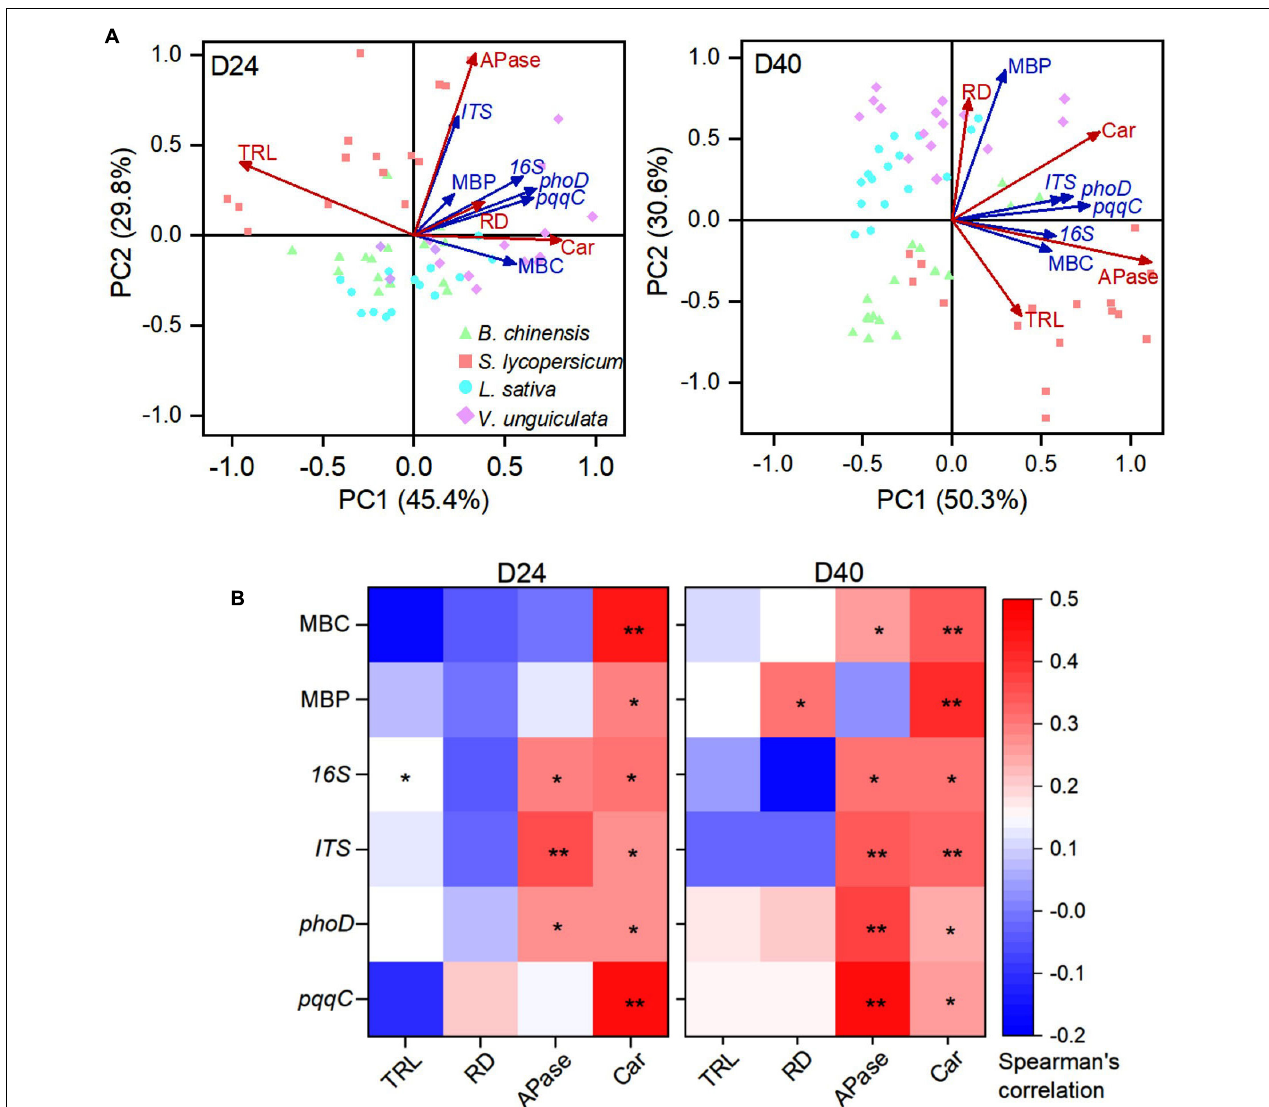
FIGURE 4 | (A) Principal component analysis (PCA) and (B) spearman’s rank correlation matrices between four root traits and six soil microbe traits B. chinensis , S. lycopersicum , L. sativa , and V. unguiculata after 24 and 40 days. D24: 24 days after straw addition, and D40: 40 days after straw addition. Root